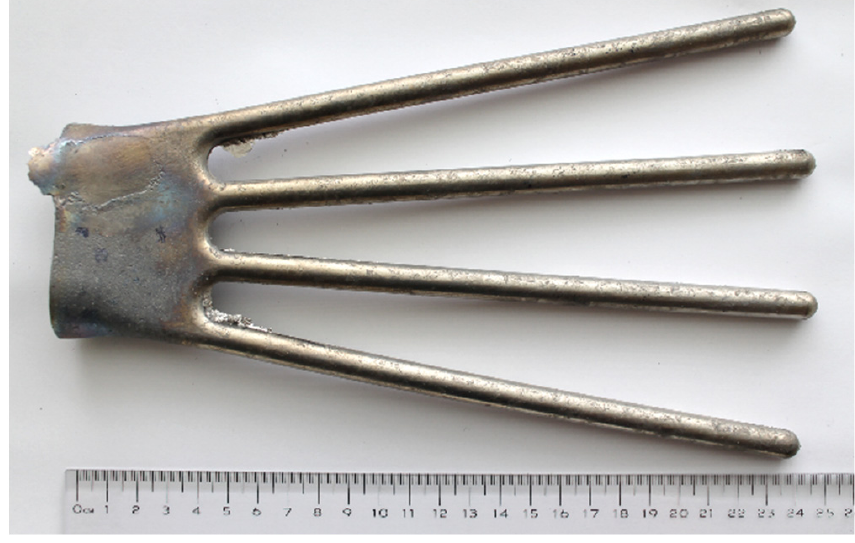
Figure 2. Casting of Ni-Al-Mo alloy.